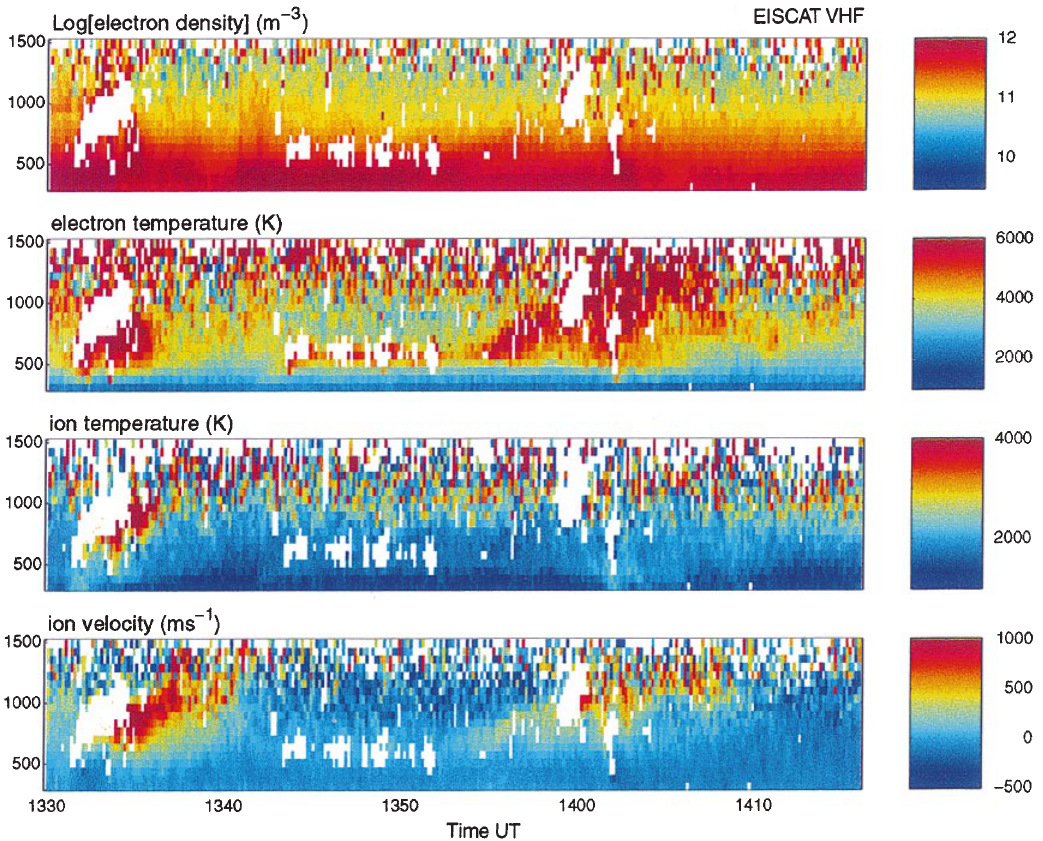
Fig. 1. Data derived from the VHF EISCAT radar during the time period 1330 to 1430 UT. Panel 1 shows an overview of the electron density, panel 2 the electron temperature, panel 3 the ion temperature